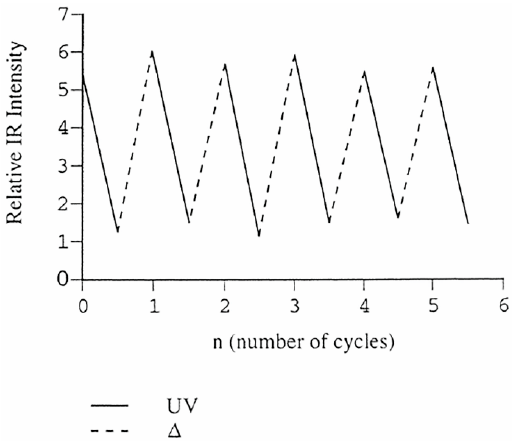
Figure 3. Reversible changes in IR intensity of E -ON=NO stretching vibration of dimer of p -bromonitrosobenzene obtained by consecutive photolysis (solid line) and thermal reactions (dotted line). Reproduced with permission from [40]. Copyright 2002 American Chemical Society.